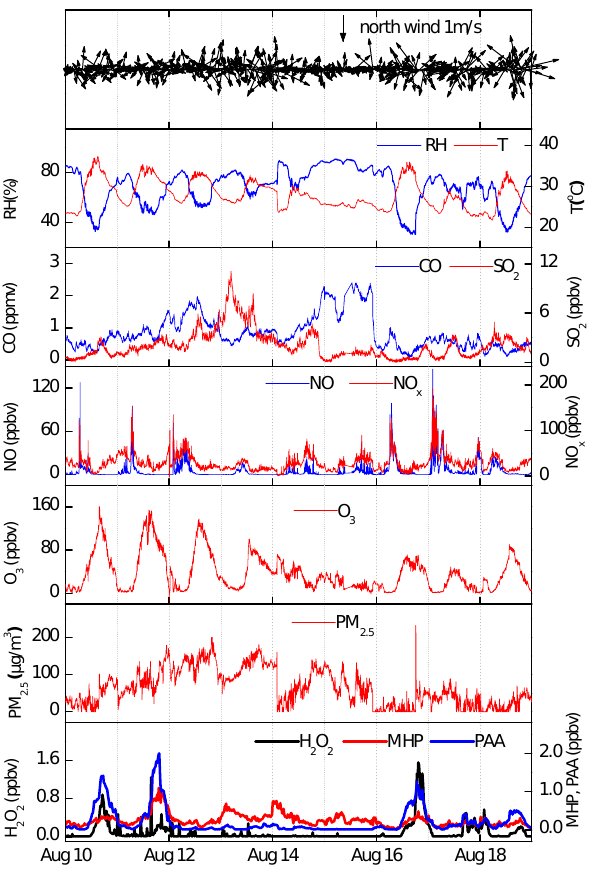
Fig. 5. Time series of observed meteorological parameters, SO 2 , CO, NO, NO x , O 3 , PM 2 . 5 and peroxides on 10–18 August 2011 (during and after the haze episode).